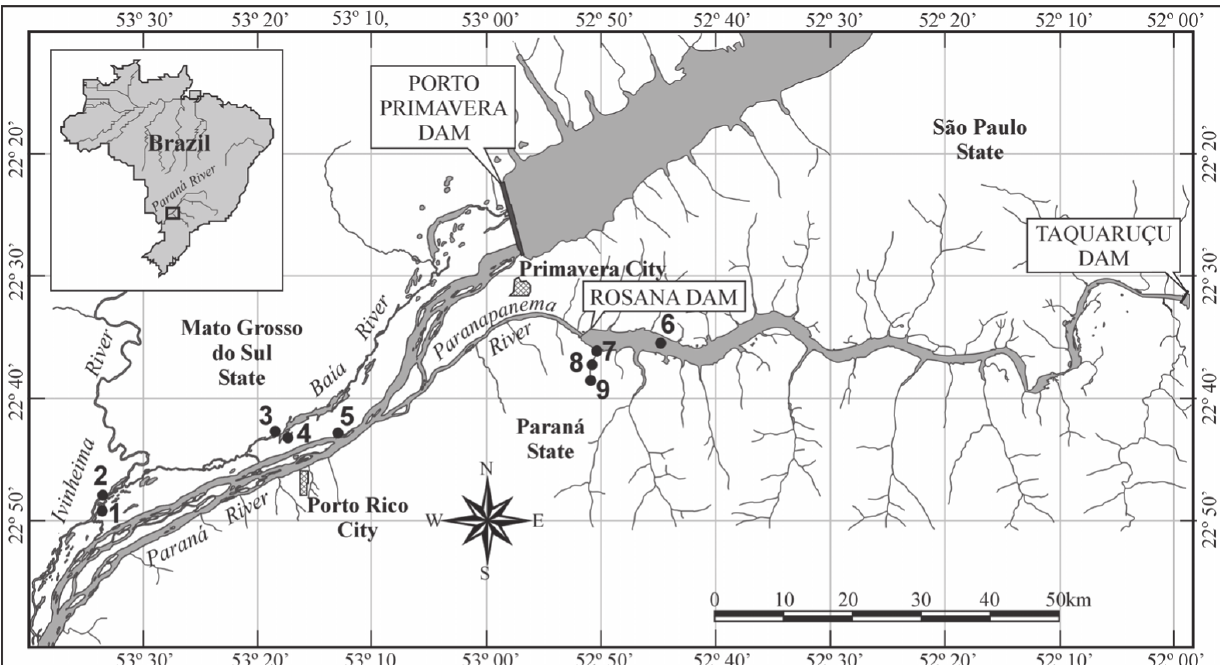
Fig. 1. Study area and location of the sampled points in the upper Paraná River floodplain (1- Patos Lake; 2- Ivinheima River; 3- Baia River; 4- Guaraná Lake; 5- Garças Lake; Rosana Reservoir (6) and Diamante Stream (7, 8 e 9). Number of specimens by sampling site: n 5, n = 56, n = 35, n = 22 and n = 6 7 8 9